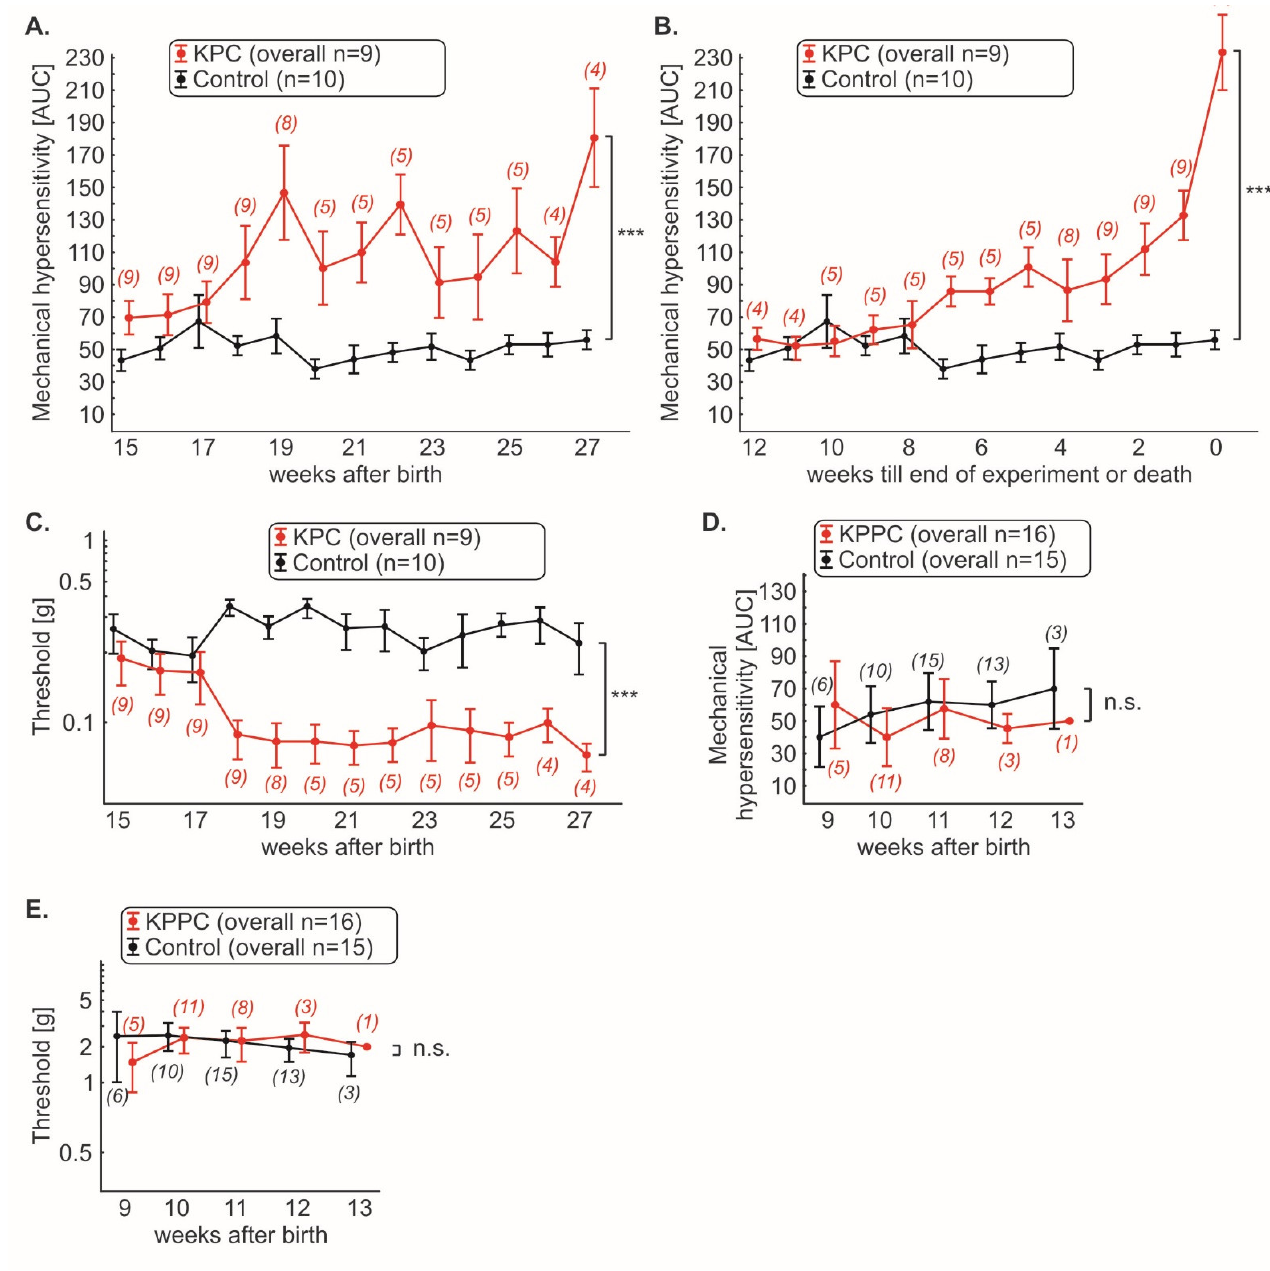
Figure 4. KPC mice, but not KPPC mice, demonstrate abdominal hyperalgesia. Mechanical hy- persensitivity in KPC and KPPC mice was quantified weekly with von Frey filaments and shown as cumulative integral of responses to abdominal stimulation (AUC) to filament strengths of 0.008 ( A , B , D ) or threshold ( C , E ). The number of mice used for the experiments varies over time and is given in brackets. Data are presented as mean ± S.E.M. Abbreviations: AUC: area under curve